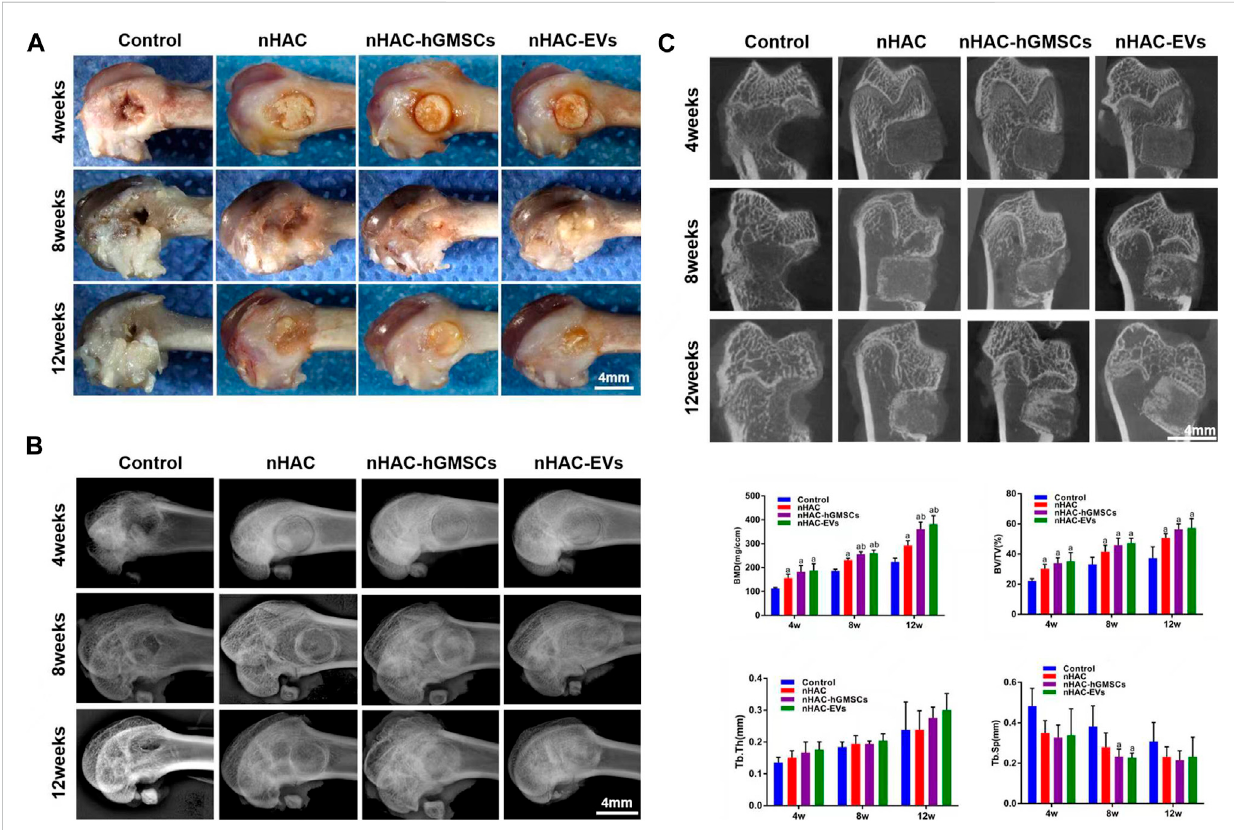
FIGURE 5 Crossobservationandimaginganalysisofboneregeneration (A) Crossobservationimagesofbonedefectsites (B) X-rayimagesofbonedefectsites (C) Micro-CT images and analysis of bone formation using BMD, BV/TV%, Tb.Th, and Tb. Sp. a, p < 0.05 compared with the control group; b, p < 0.05 compared with the nHAC